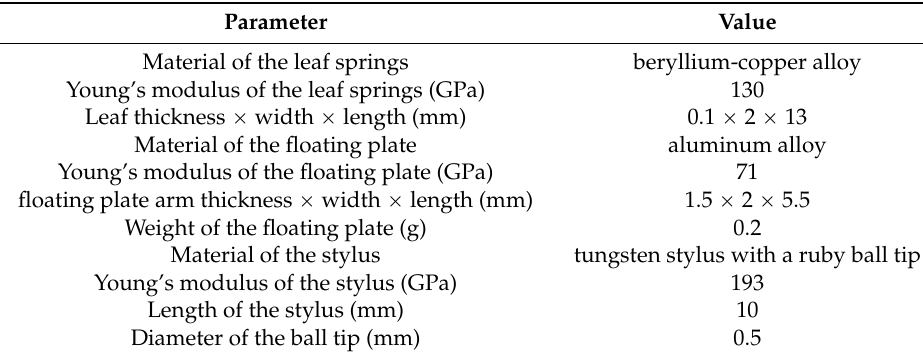
Table 1. The parameters of the probe.